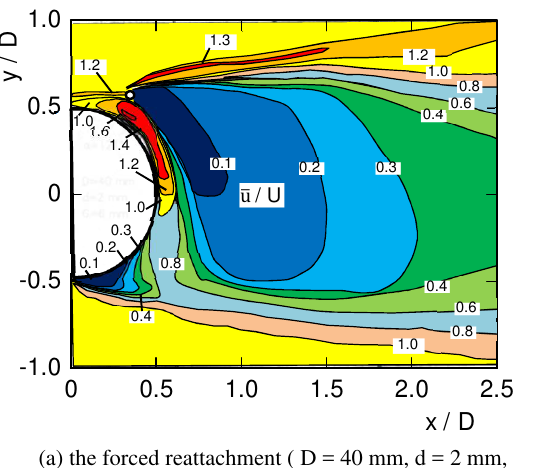
(b) single circular cylinder ( D = 40 mm, Re = 1.6 · 10 4 )